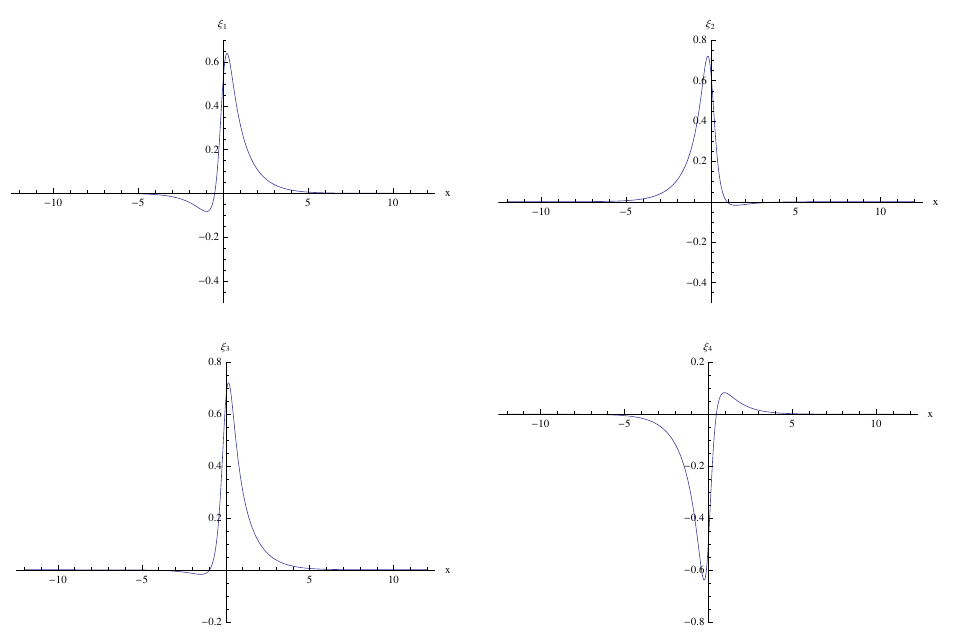
Figure 10 . The analytical bound state of the fermion as a function of x for the positive parity σ = 1 . It is plotted for ρ 1 = 0 . 41 , ρ 2 = − 0 . 65 , θ 1 = 0 . 138 , θ 2 = 0 . 85 , κ = 1 , θ 0 = 2 π/ 3 . Notice the spinor components relationships ξ 1 ( − x ) = − ξ 4 ( x ) and ξ 2 ( − x ) = + ξ 3 ( x ) .